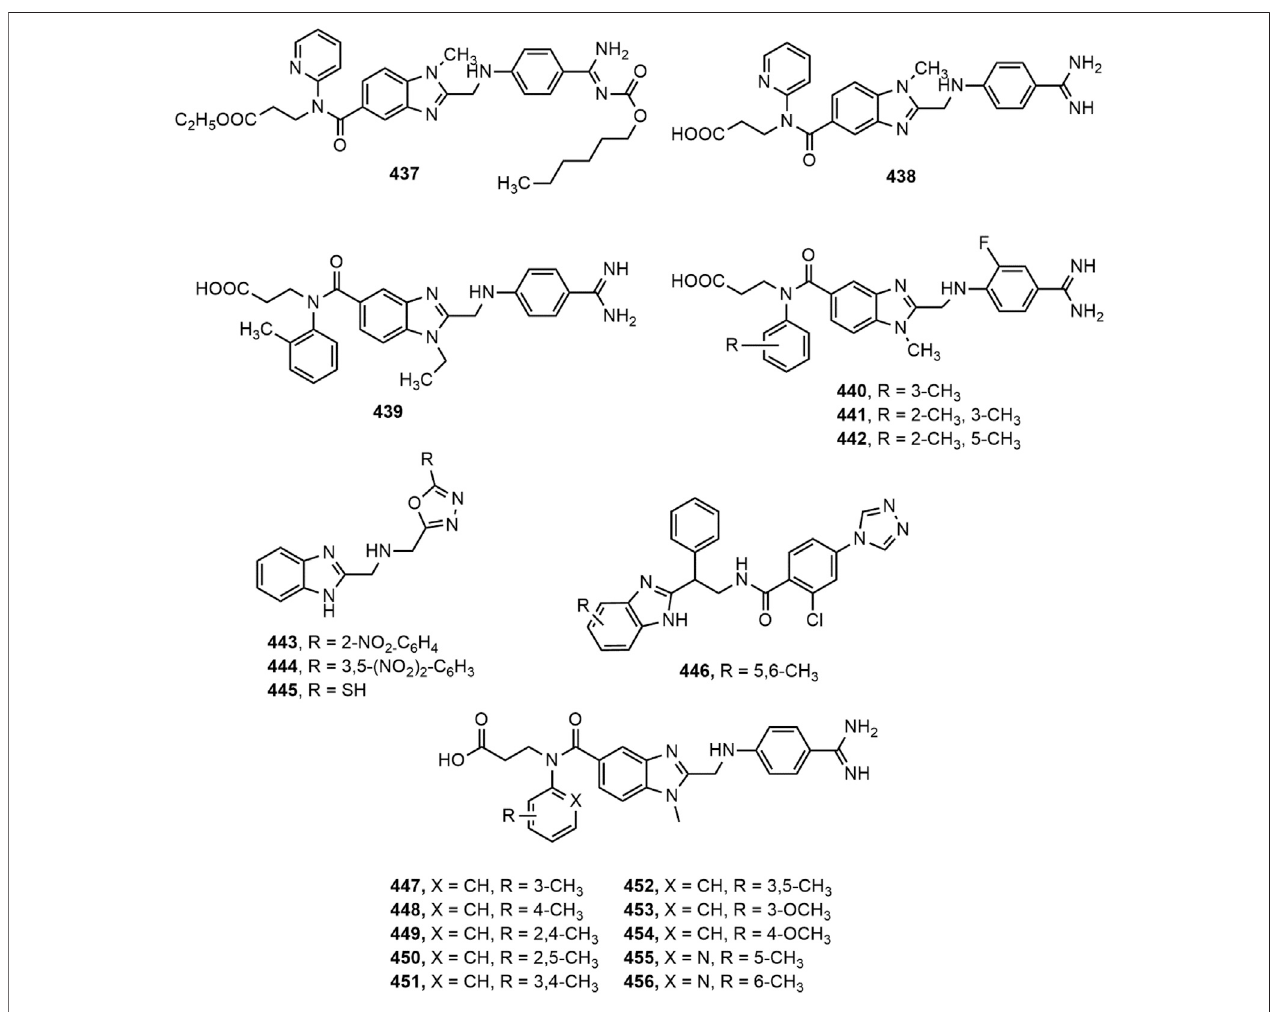
FIGURE 18 | Benzimidazole derivatives with anticoagulant activity.